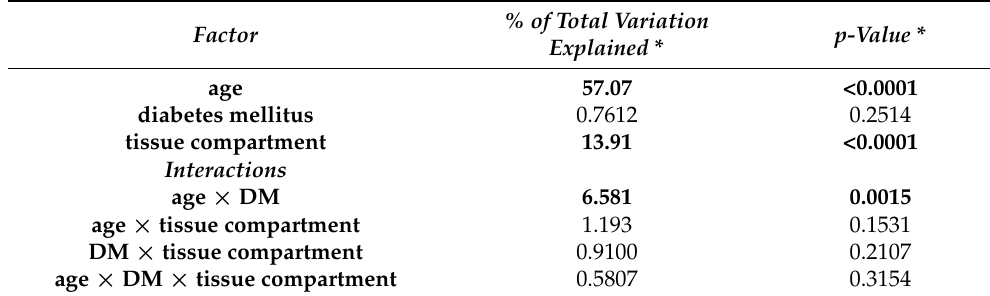
Table 1. Effects of age, diabetes mellitus (DM) and tissue compartment on expression of MSH2. % of Total Variation Factor Explained